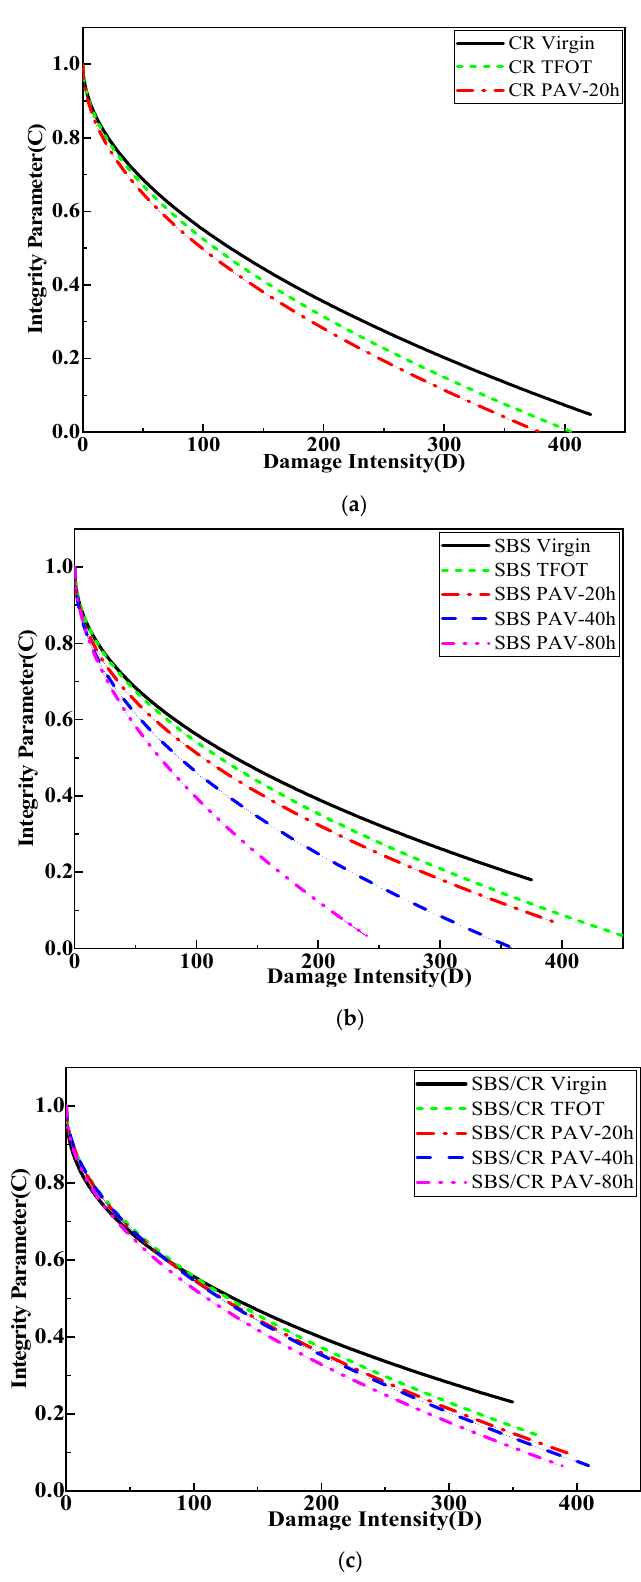
Figure 5. Effect of aging on the curve of integrity parameter vs. damage versus of Crumb Rubber modified bitumen (CRMB), SBS modified bitumen (SBSMB) and SBS/CRMB, ( a ) CR modified binders; ( b ) SBS modified binders; ( c ) SBS/CR composite modified binders.